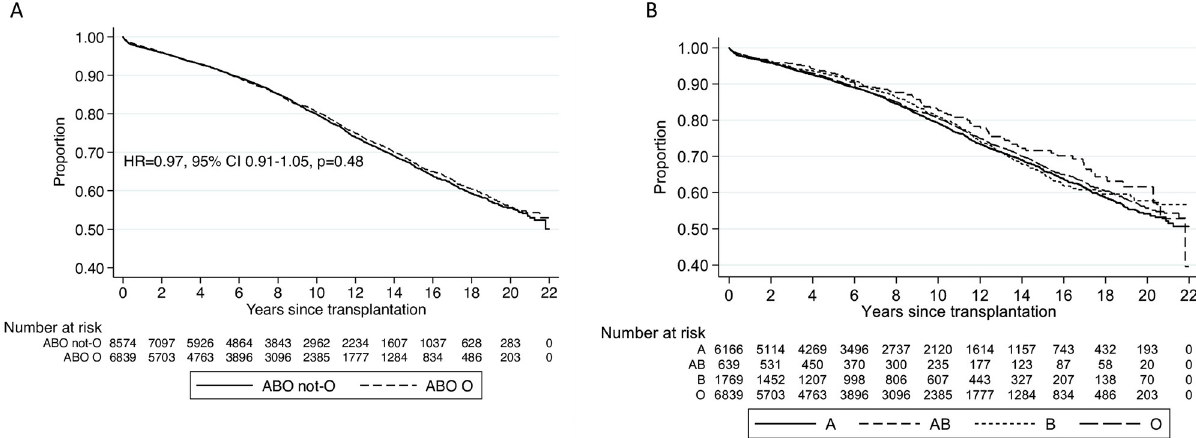
Fig 1. Kaplan Meier survival curve for cumulative patient survival post-transplant by recipient ABO blood group. (A) Recipient blood group O vs. non-blood group O. (B) All recipient blood groups.